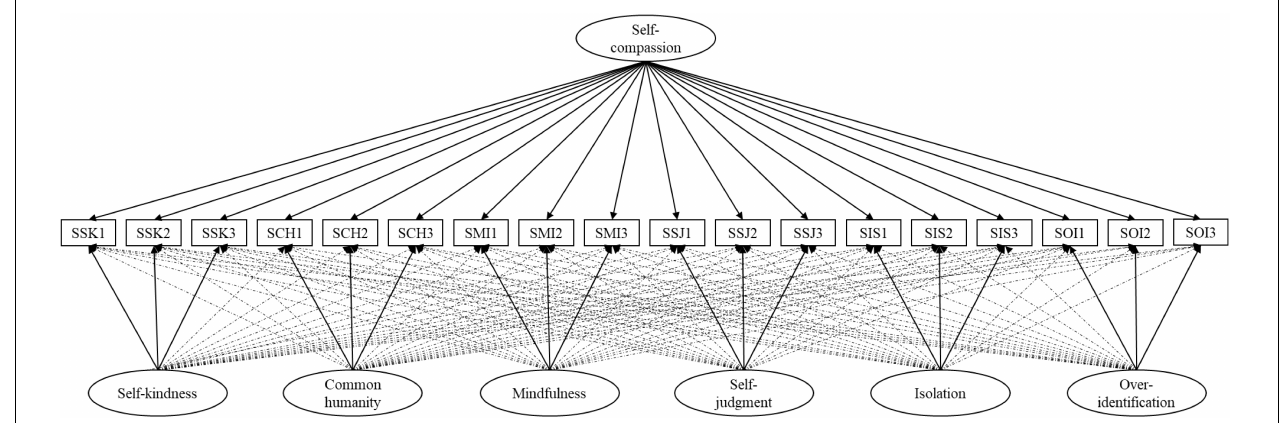
FIGURE 1 | Graphical depiction of the bifactor ESEM representation of self-compassion. SSK, state self-kindness; SSJ, state self-judgment; SCH, state common humanity; SIS, state isolation; SMI, state mindfulness; SOI, state over-identification. Ovals represent latent variables and squares represent questionnaire items. Unidirectional solid lines represent target paths, unidimensional dashed lines represent